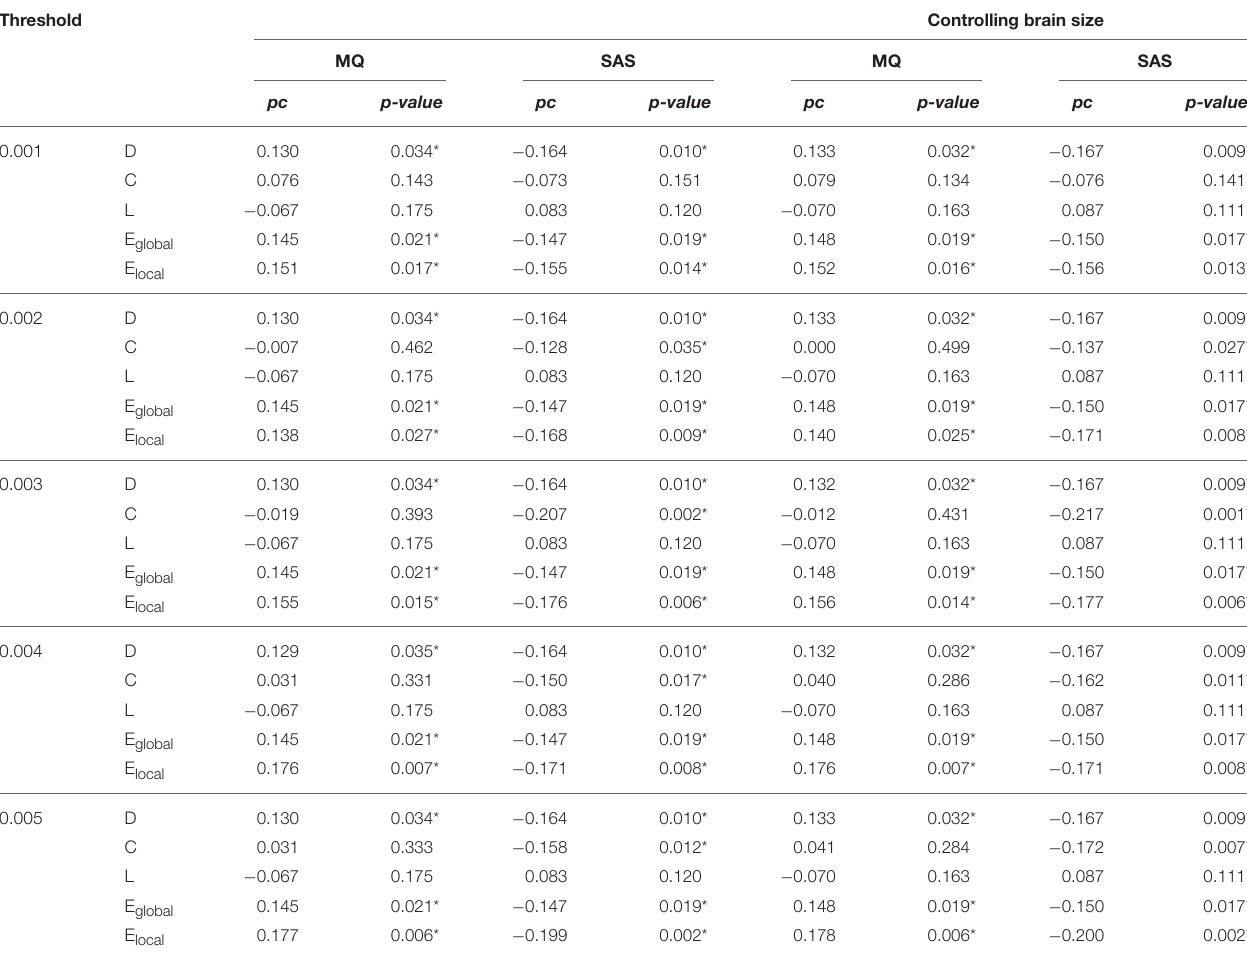
TABLE 1 | Partial correlations between the MQ, SAS scores, and the global network properties of the whole DMN with or without controlling the brain size under different thresholds.